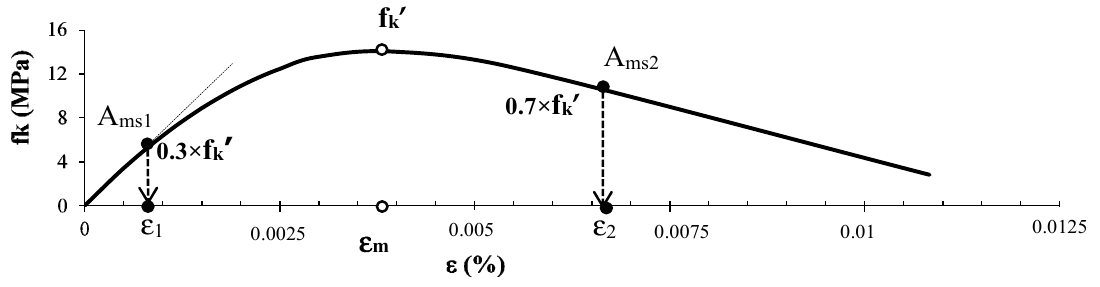
Figure 4. Stress-strain relation for three masonry infill types according to Kaushik [36]. For nonlinear FEM analysis, Mander’s model [37] for concrete and Menegotto-Pinto’s model [38] for reinforcement are used to define the force-based plastic hinge (FBPH) fiber elements, while masonry infill model is based on inelastic infill panel element (Table 7) defined by strut / shear curve properties [32]. The masonry infill wall was modelled as the infill panel model with calibrated parameters of hysteretic behavior. The initial diagonal width w 1 was determined according to proposal of Sta ff ord et al. [39]. It is based on the parameter λ h which presents a measure of the relative sti ff ness of the frame to infill. The reduced area A ms2 of the compressed diagonal depends on the sti ff ness coe ffi cient λ h , according to the recommendations of Decanini [40]. Corresponding deformations were determined according to the limit states: the start of reduction of the initial area A ms1 corresponds to the deformation at the end of linear elastic behaviour ( ε m / 3) while the A ms2 secondary area is reached at 70% of the maximum compressive stress and the associated strain corresponds to the 1.5 × ε m (Figure 5).